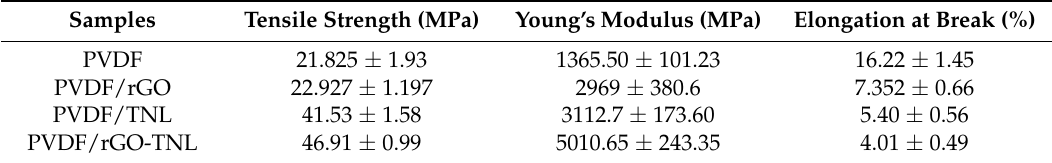
Table 2. Tensile test results of PVDF/rGO-TNL, PVDF-TNL, PVD-rGO and PVDF. Samples